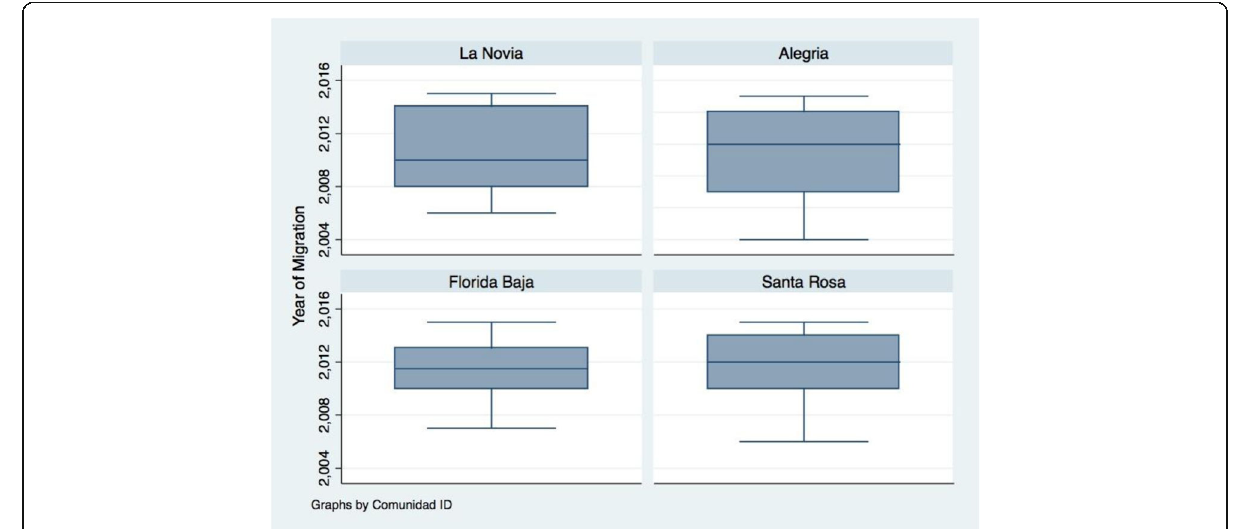
Fig. 3 Comparison of arrival date by community for migrants arriving between 2000 and